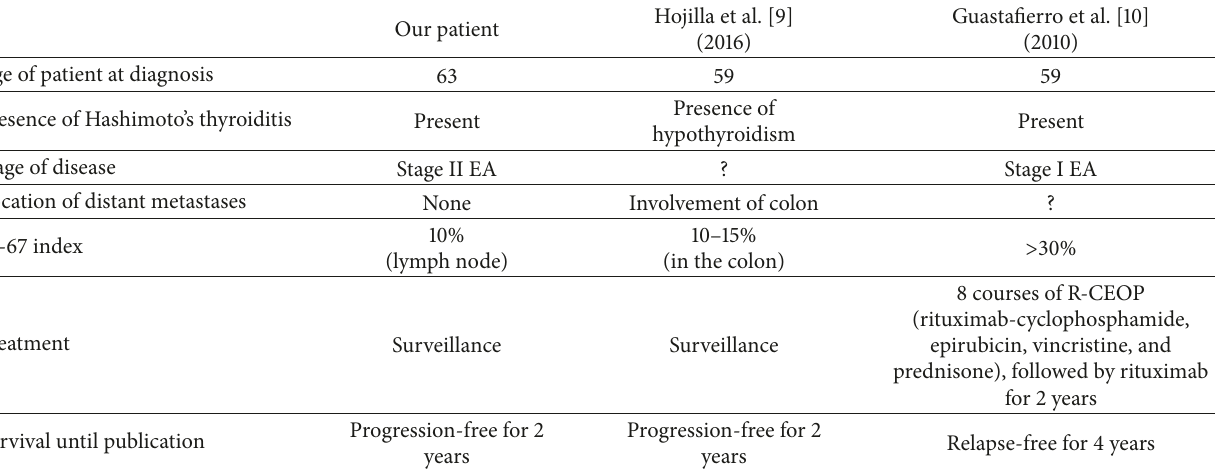
Table 1: Comparing our patient to another 2 cases reported in